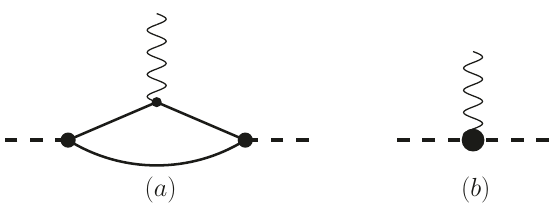
Figure 1 . a) The triangle diagram which leads to an irregular behavior of the matrix element in a finite volume, and b) a local vertex that has a regular behavior. The dashed, single and wiggled lines denote the resonance, its constituents and the external current,